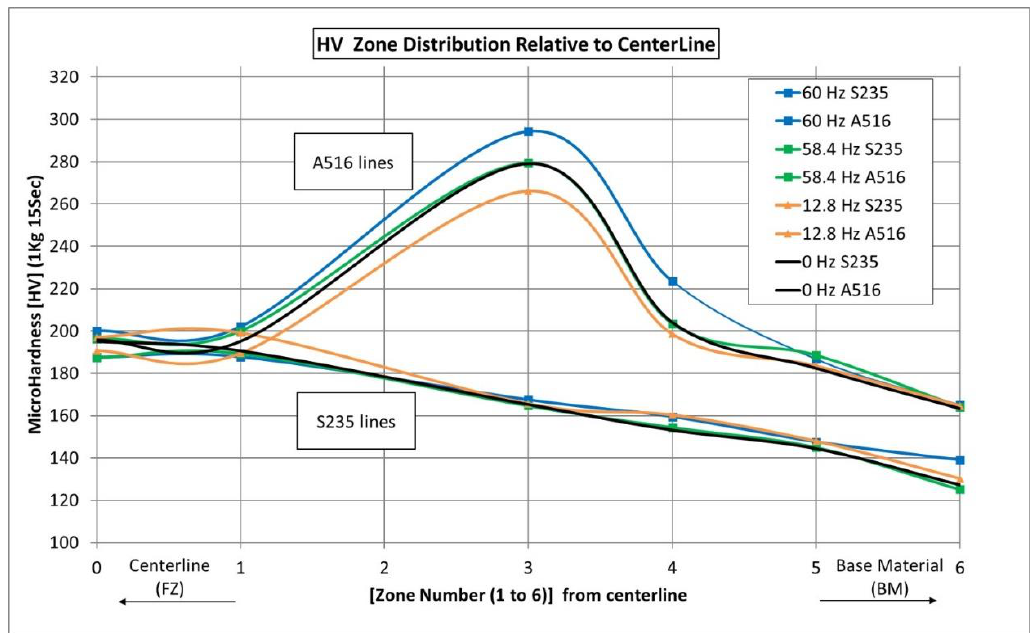
Figure 9. Position of different microhardness indents along the scan line and the corresponding microstructure.